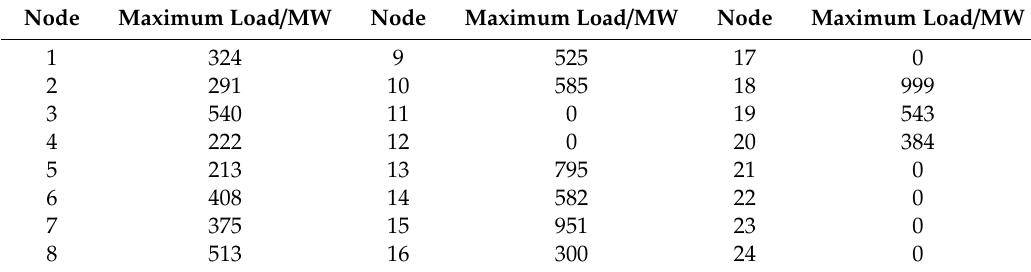
Table A5. IEEE RTS-24 system maximum node load.